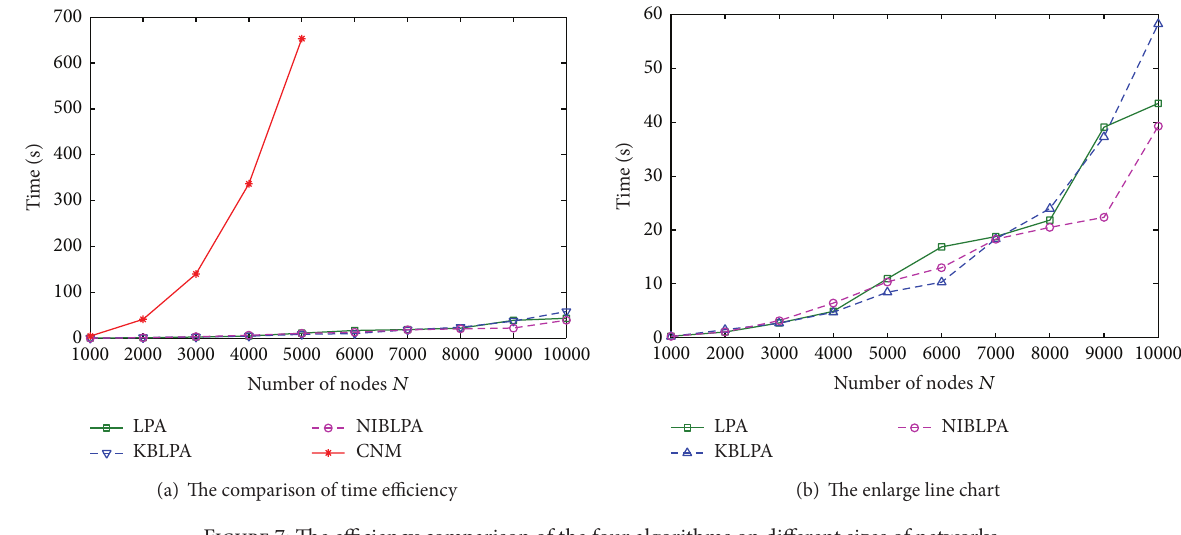
Figure 7: The efficiency comparison of the four algorithms on different sizes of networks.